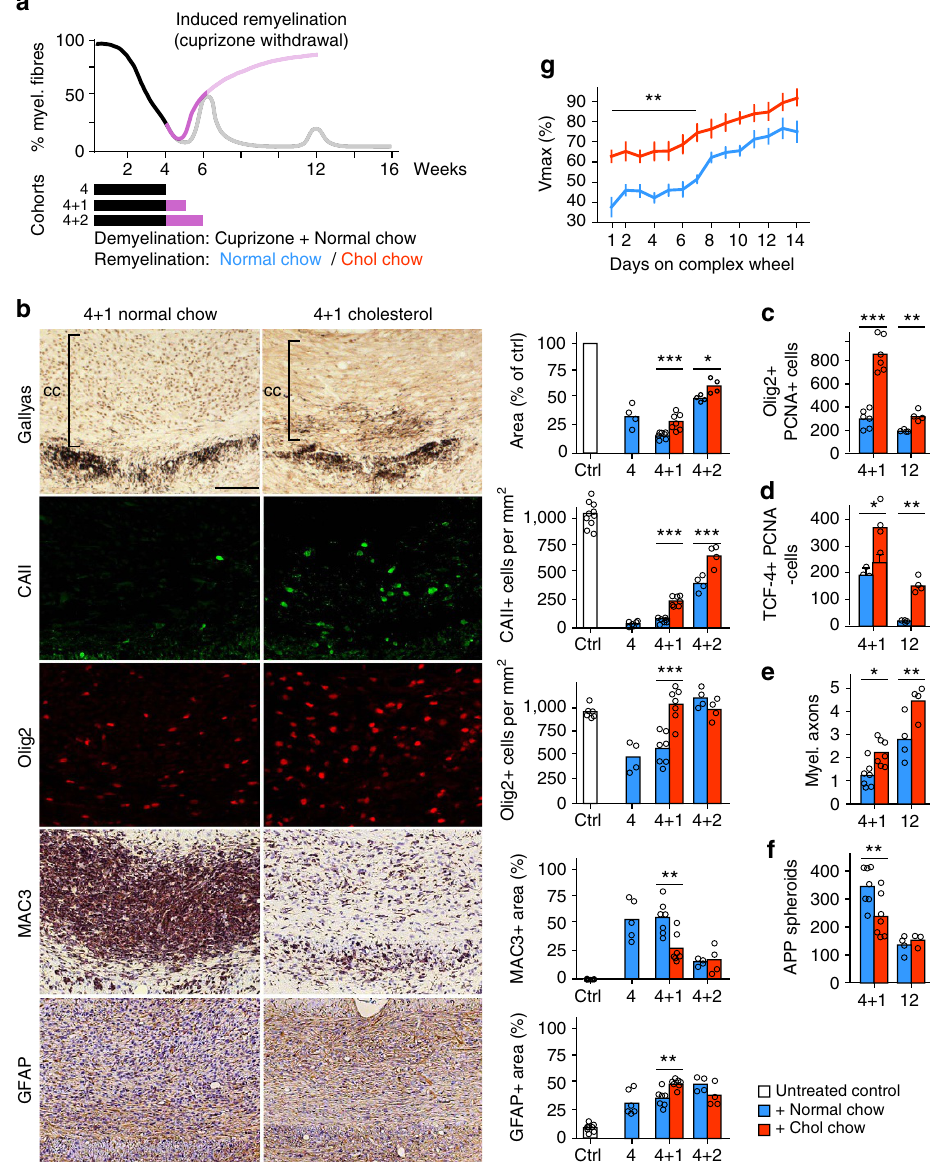
Figure 5 | Cholesterol facilitates remyelination after cuprizone withdrawal. ( a ) Scheme depicting the time course of demyelination/remyelination during cuprizone feeding (remyelination after cuprizone withdrawal in purple). The influence of cholesterol on remyelination was assessed by feeding mice cuprizone in normal chow for 4 weeks (4, black bars) followed by ‘induced remyelination’ after cuprizone withdrawal for 1 (4 þ 1) or 2 (4 þ 2) weeks on normal chow or cholesterol supplemented chow. ( b ) Representative pictures of the corpus callosum of mice after one week (4 þ 1) remyelination. Corresponding quantification is on the right also including values for 2 weeks remyelination (4 þ 2). Assessed were myelination (Gallyas silver impregnation), the number of mature oligodendrocytes (CAII), the number of oligodendrocyte lineage cells (Olig2), activated microglia (MAC3), and astrocytes (GFAP). Each bar represents the mean value from n ¼ 4–5 (4 and 4 þ 2) or n ¼ 7 (4 þ 1) animals (scale, 100 m m; Two-way ANOVA and Sidak’s post test). ( c ) Quantification of proliferating OPCs (PCNA positive Olig2 positive) in the corpus callosum of mice after 4 þ 1 treatment paradigm (4 þ 1) or after 12 weeks (12) of cuprizone. Each bar represents the mean of n ¼ 6–7 (week 4 þ 1), or n ¼ 4 (week 12) animals (Student’s t -test). ( d ) Quantification of newly differentiated postmitotic oligodendrocytes (TCF4 positive, PCNA negative) in the corpus callosum treated as in c ). Each bar represents the mean of n ¼ 6–7 (week 4 þ 1), or n ¼ 4 (week 12) animals (Student’s t -test). ( e ) Myelinated axons per 10 m m 2 in the corpus callosum at the end of the 4 þ 1 ( n ¼ 7) and 4 þ 2 ( n ¼ 4) treatment paradigm (two-way ANOVA and Sidak’s post test). ( f ) APP positive spheroids per mm 2 in the corpus callosum (4 þ 1 n ¼ 7; 4 þ 2 n ¼ 3–4 animals, two-way ANOVA and Sidak’s post test). ( g ) Motor learning as assessed by maximum velocity (Vmax) on a complex wheel ( n ¼ 6 animals), expressed as per cent of the Vmax on a training wheel (mean of the last 7 days before changing to a complex wheel). Statistical evaluation of Vmax was done by Two-way ANOVA (cholesterol effect P o 0.0001) and Sidak’s post tests. Asterisks represent significant differences with * P o 0.05; ** P o 0.01; *** P o